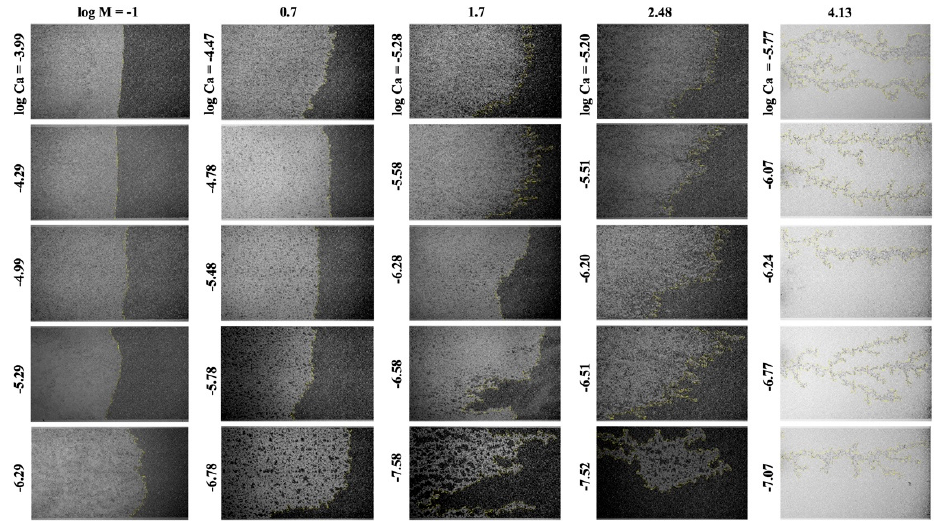
Figure 2. Image of displacement fronts in drainage experiments.